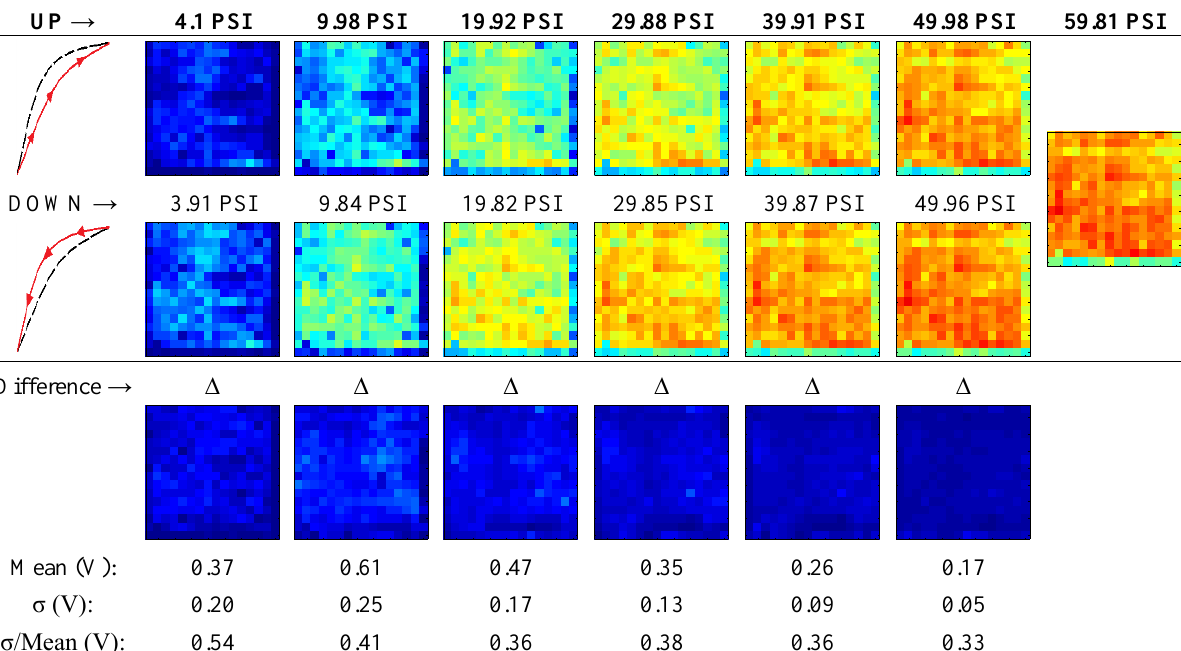
Figure 3. ( a ) Average output and standard deviation (at the bottom) from the PCB based sensor; ( b ) Average output from the commercial sensor. Table 1. Tactile images from the PCB based sensor obtained for a uniform pressure that follows and increasing-decreasing